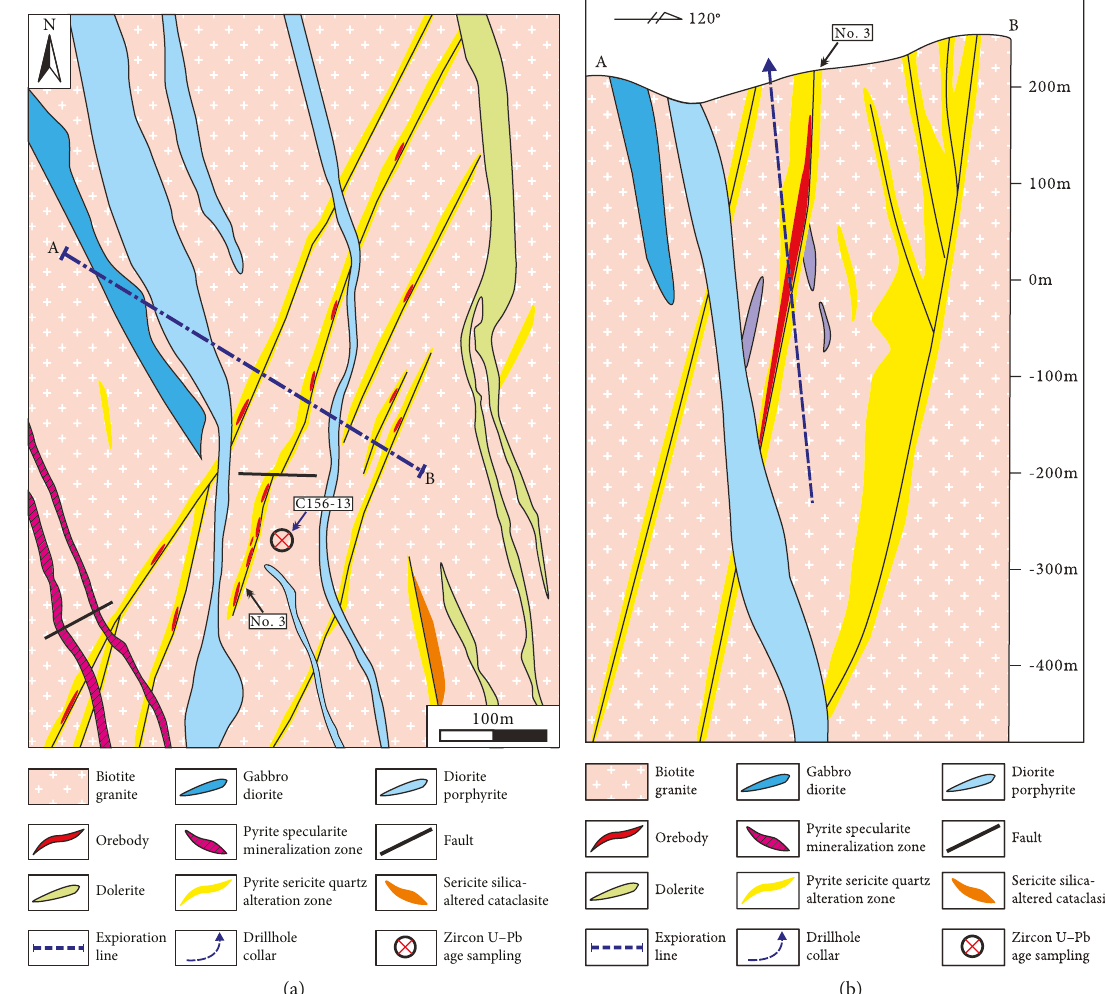
Figure 2: (a) Geological sketch map of the Xiejiagou gold deposit; (b) geological section of the Xiejiagou gold deposit (modi fi ed after Ding